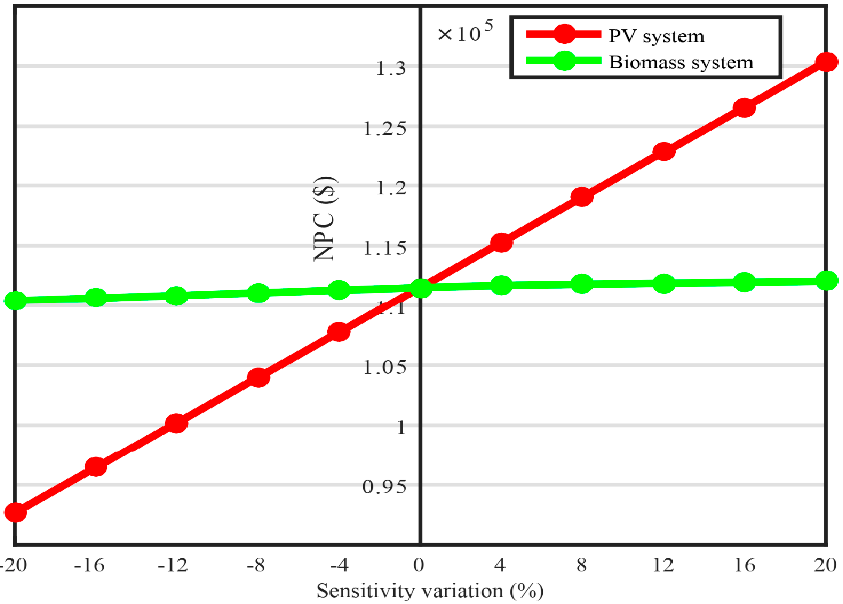
Figure 11. Sensitivity analysis application for net present cost (NPC).